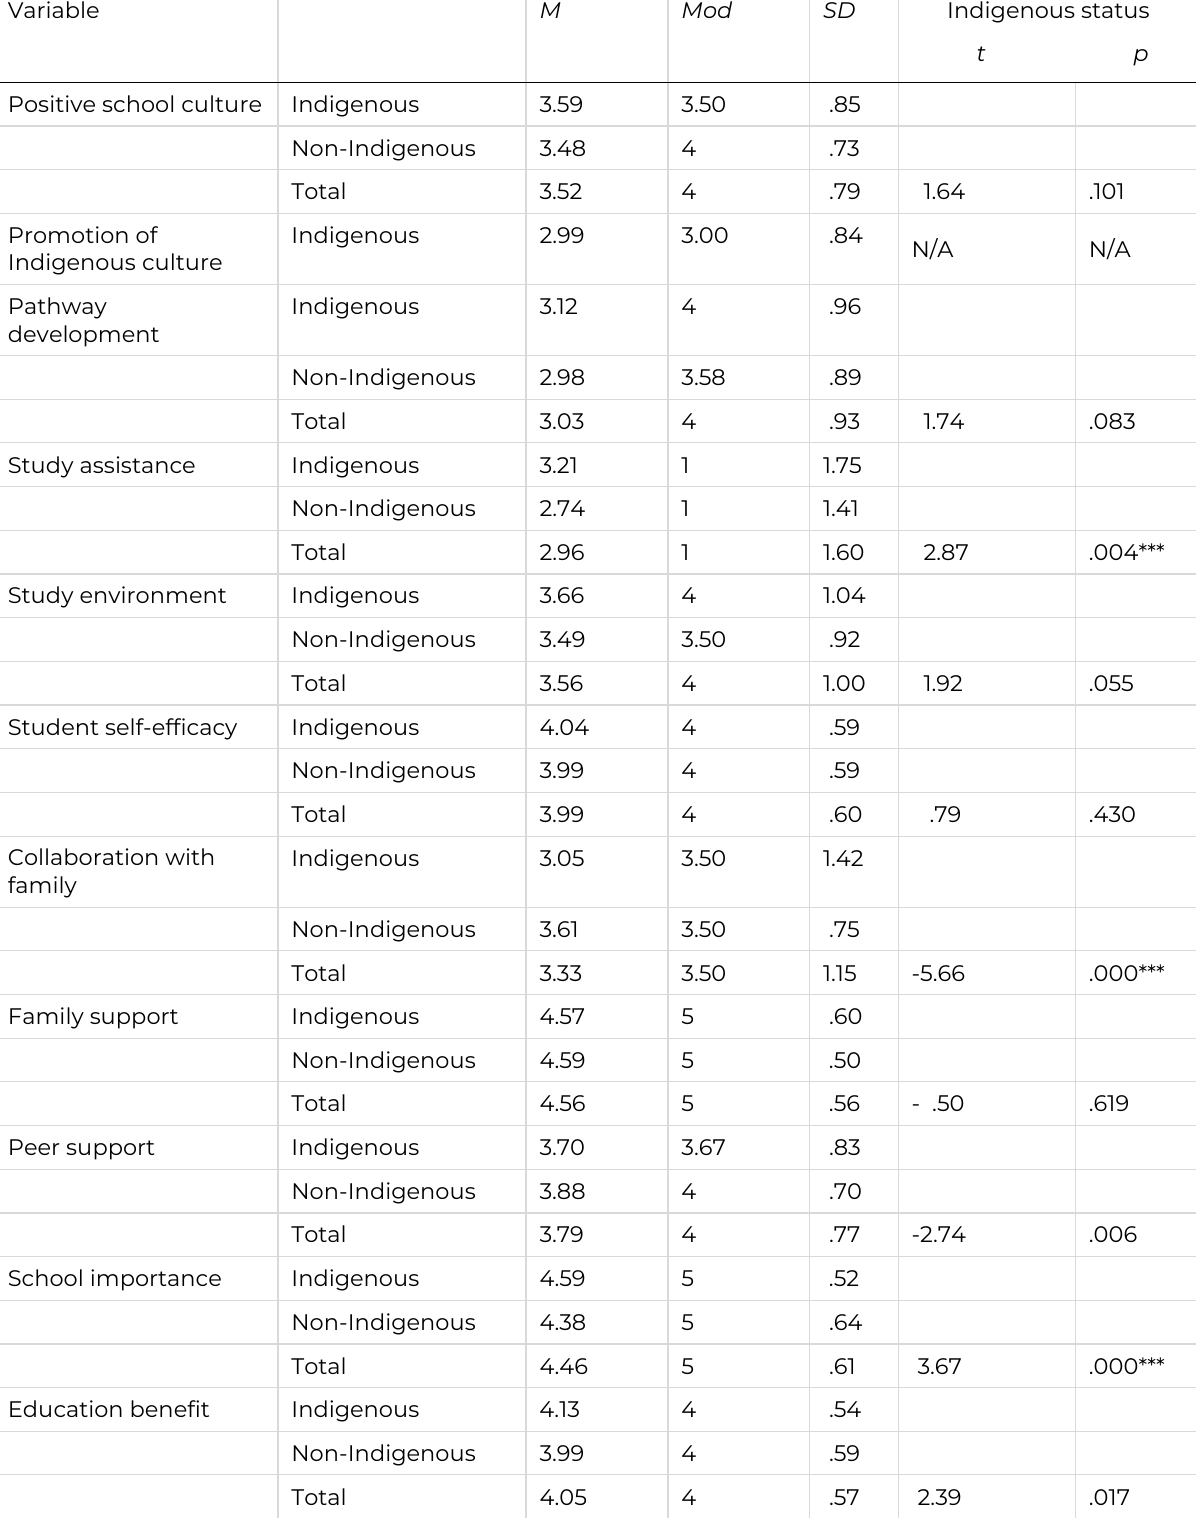
Table 4. Descriptive and inferential statistics, separated by Indigenous status Variable M Mod